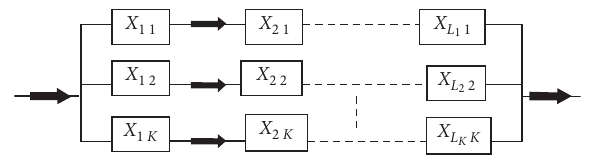
Figure 1: System with a parallel-series